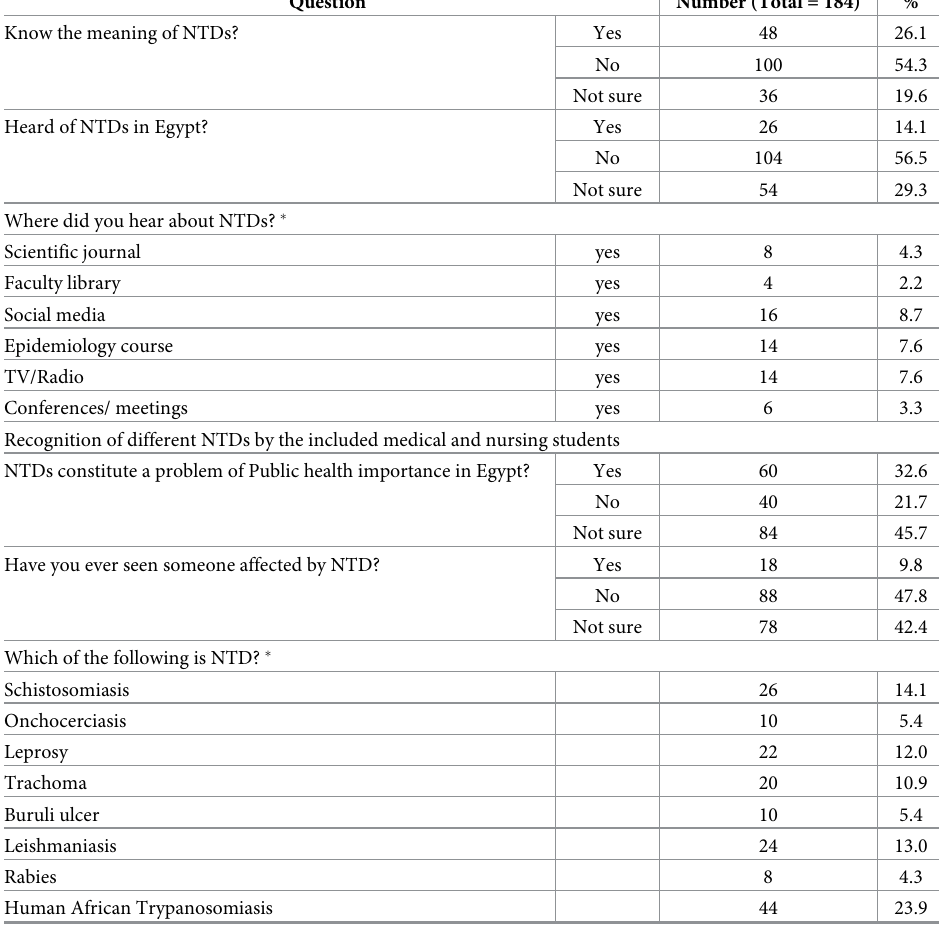
Table 2. Knowledge of the included medical and nursing students in Cairo University regarding NTDs.